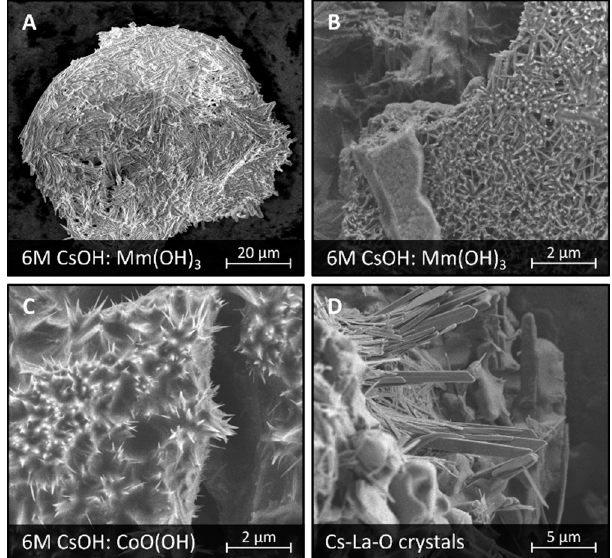
Figure 3. SEM images of a surface of LaMm-Ni 4.1 Al 0.3 Mn 0.4 Co 0.45 alloy after electrochemical treatment at 6 M CsOH showing surface formations of: Mm(OH) 3 ( A , B ), CoO(OH) ( C ), and Cs-La-O ( D ).